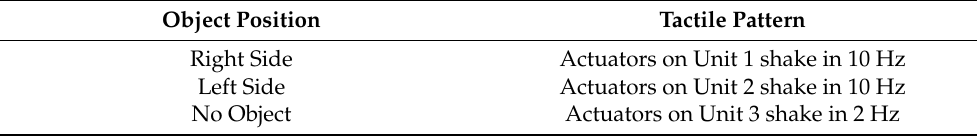
Table 4. Relationships between a detected object and a tactile pattern using tactile display 1.